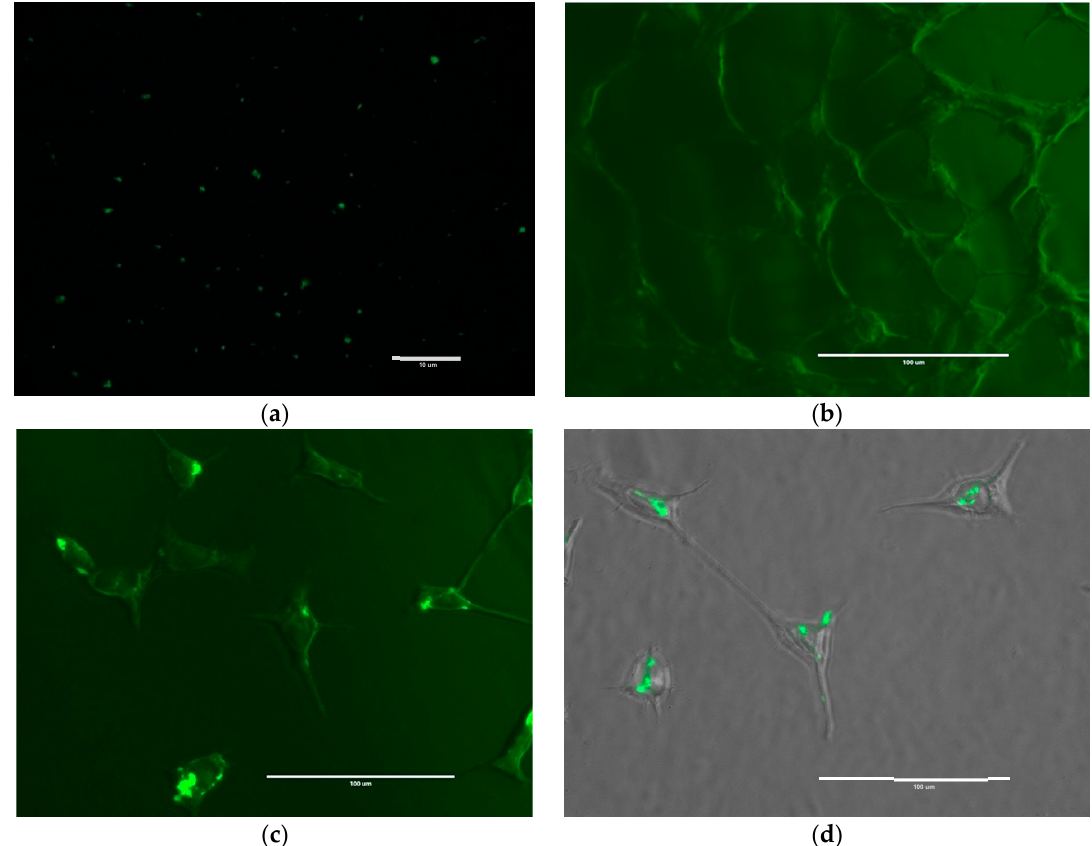
Figure 11. Fluorescein isothiocyanate (FITC)-labelled γ -PGA-chitosan NPs; ( a ) Labeled NPs suspended in deionised water at a concentration of 5 mg/mL. Magnification power × 1000. Scale bar, 10 µ m; ( b ) HEK293 cells not exposed to labeled NPs used as a control; ( c ) HEK293 cells exposed to FITC-labeled NPs; ( d ) overlaying image of HEK293 cells exposed to FITC-labeled NPs. Magnification power × 400. Scale bar, 100 μ m.